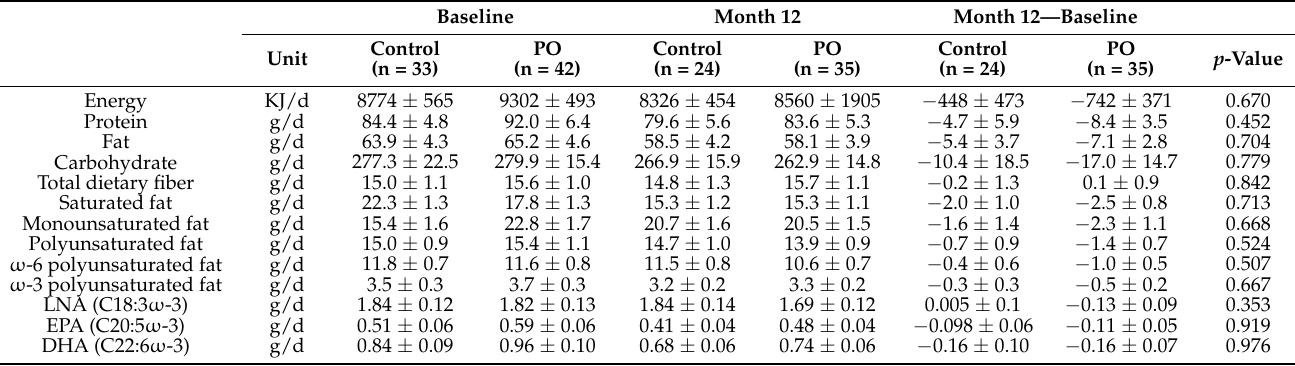
Figure 1. Flow diagram of participant selection. Table 3. Dietary intake evaluated by the BDHQ before and after intervention in the control and perilla seed oil-intake groups.